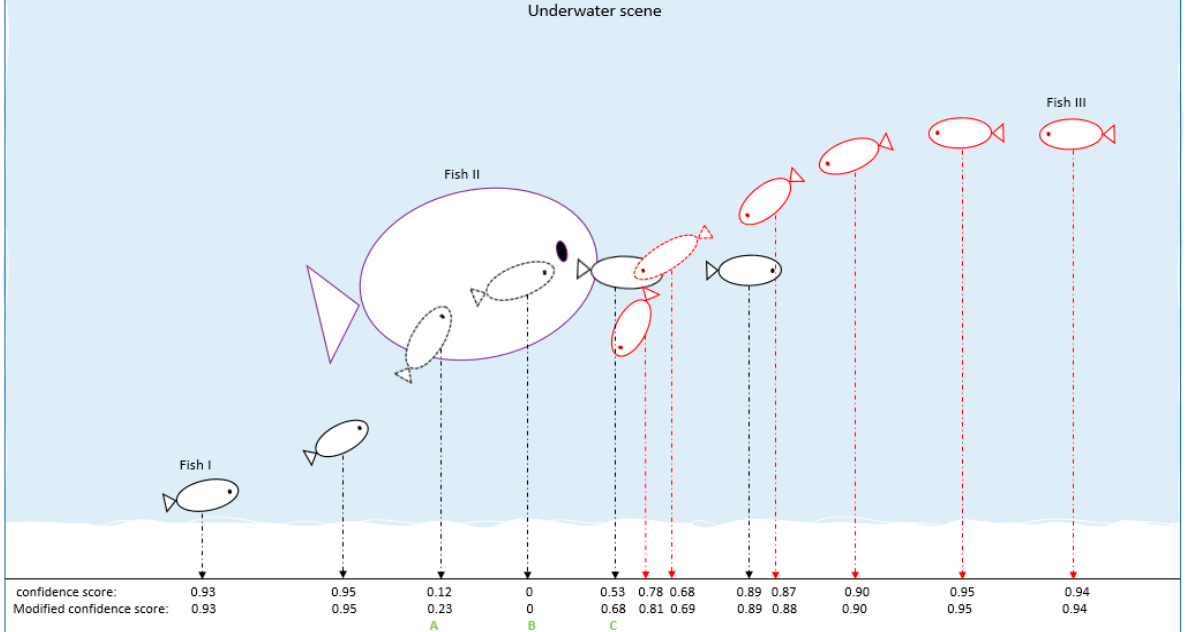
Figure 2. Underwater occlusion scene. Three fish scenarios were simulated, and the confidence scores before and after revision are listed. The A, B and C are three time points.